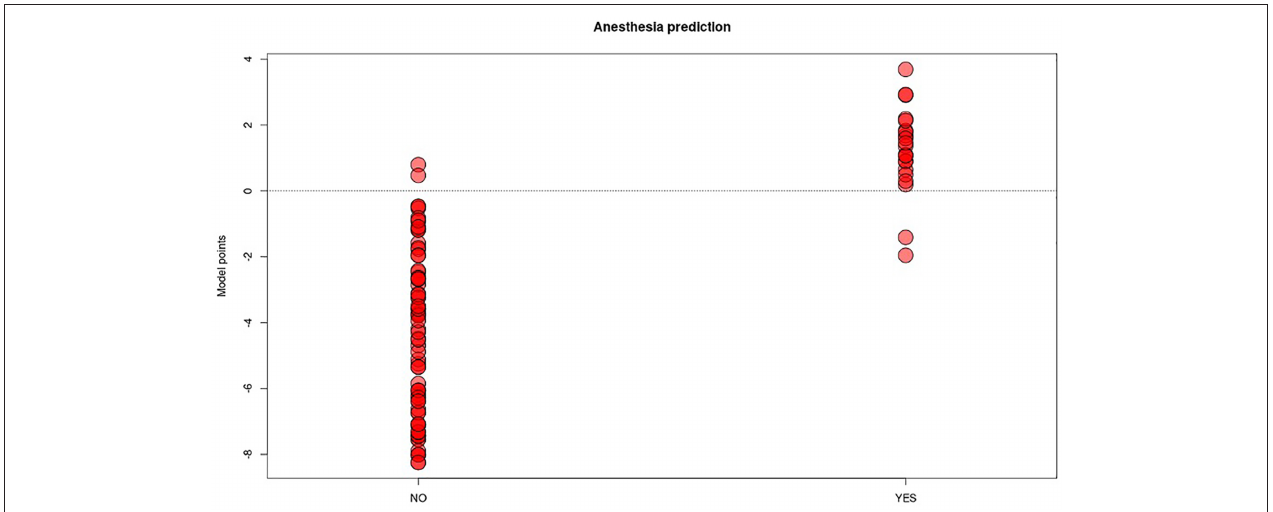
FIGURE 3 | Distribution plot of “anesthesia” predictive model score (y axis) in the two groups of patients undergoing (YES) or not (NO) to anesthesia procedure. The red dots represent each patient in the two groups, the threshold line chosen to best split the two categories is the score 0.